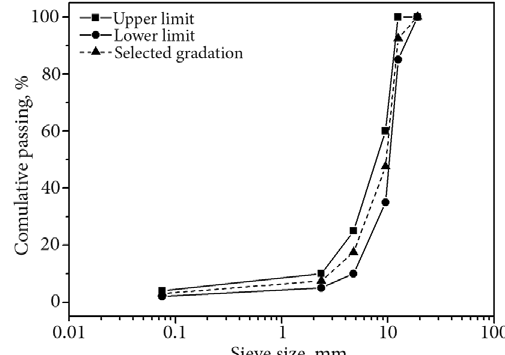
Fig. 3. Grain size distribution curves of filler materials